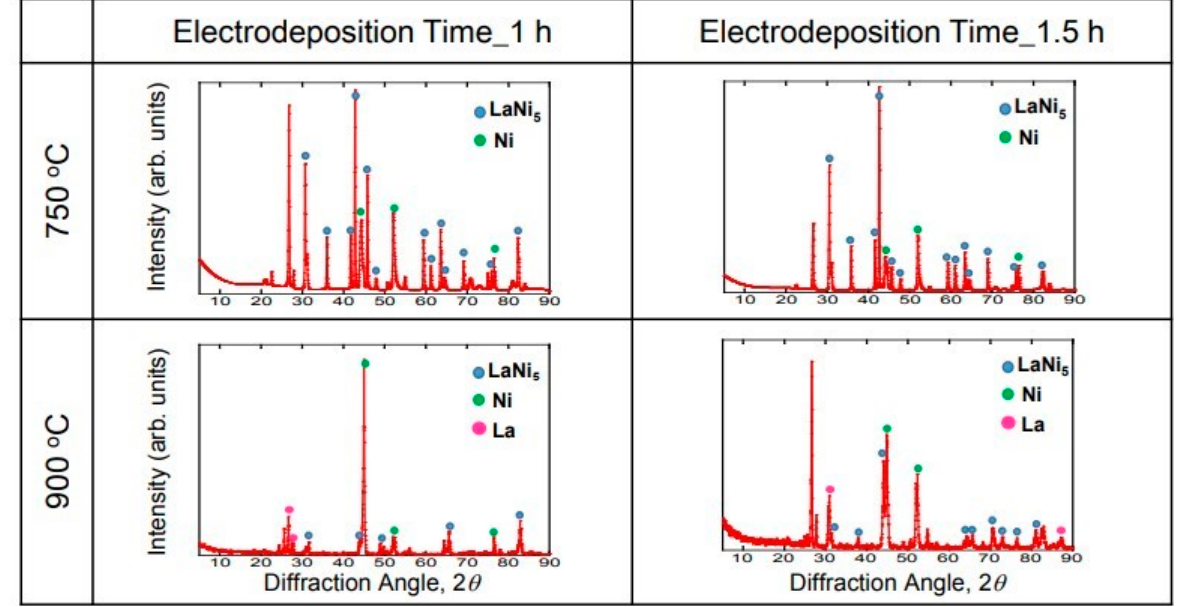
Figure 6. X-ray diffraction patterns of Ni after La deposition at − 2.25 V in NaCl-KCl-5.0 mol%LaF 3 melts at 750 ◦ C and 900 ◦ melts at 750 °C and 900 °C.